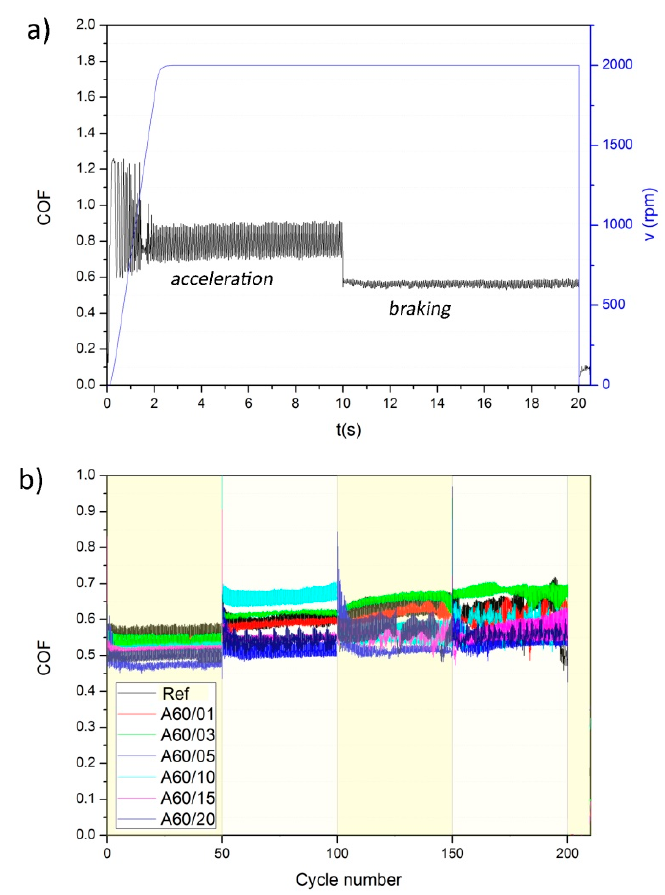
Figure 2. ( a ) Example of a generic friction curve obtained during the whole Pin-On-Disk experiment: COF and v(rpm), and ( b ) COF curves for different ELT rubber particle concentrations at 50, 100, 150, and 200 cycles of friction.